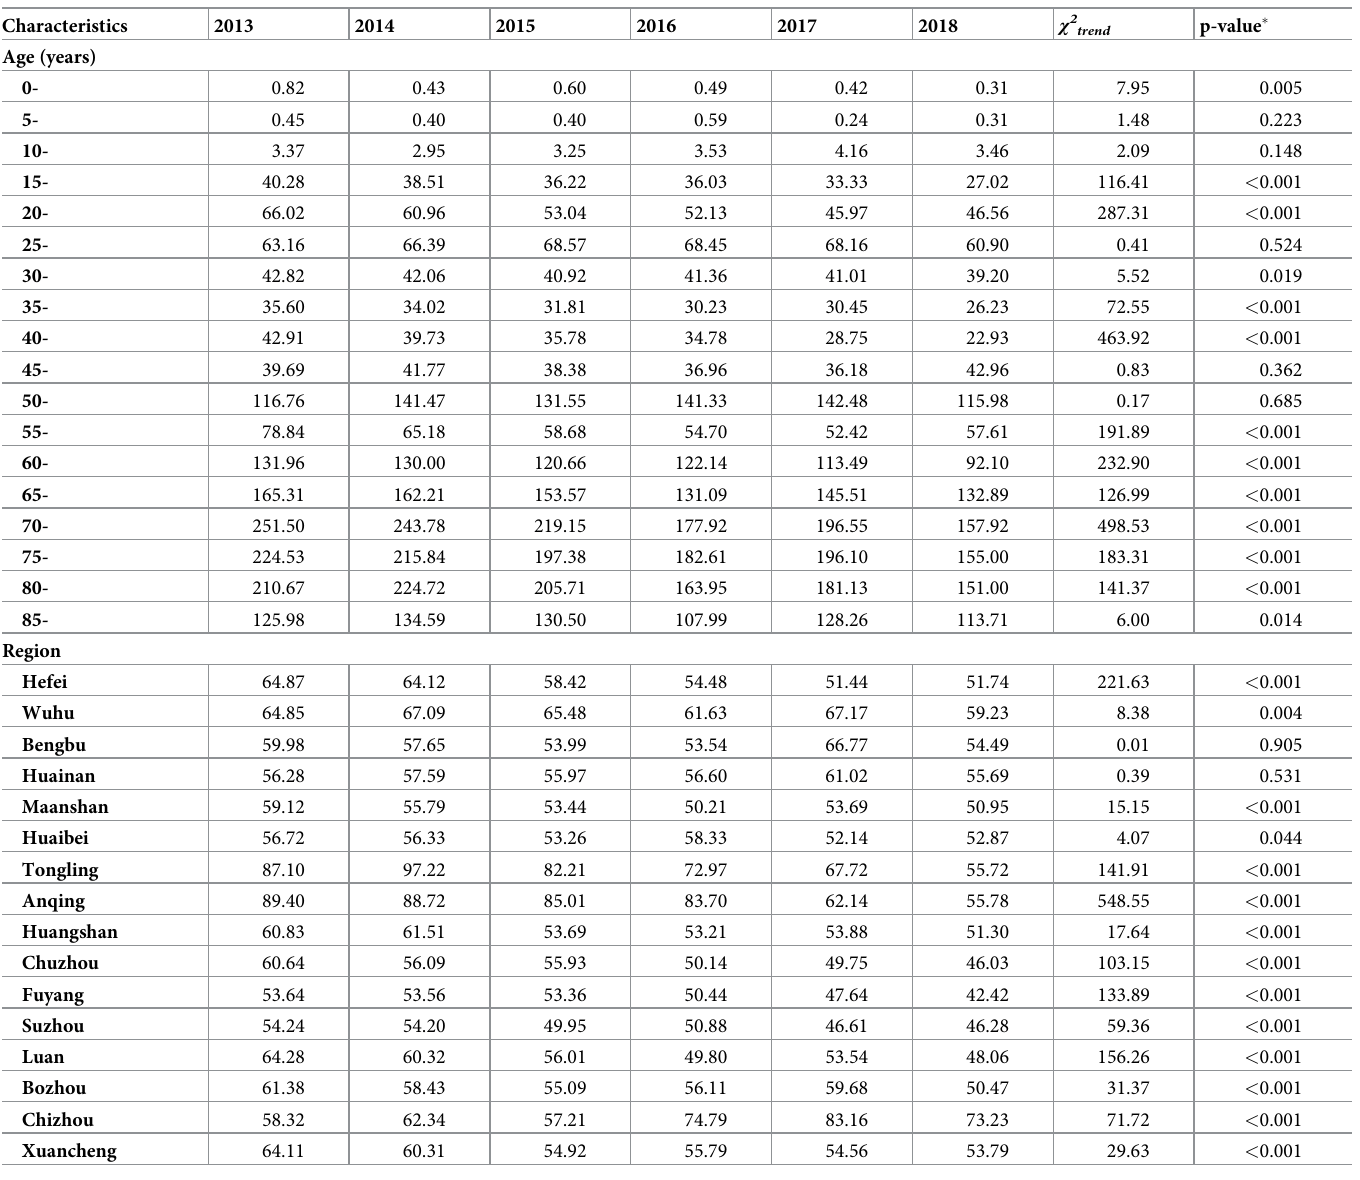
Table 2. Trends in pulmonary tuberculosis incidence rates by age and region in Anhui province, Eastern China, 2013–2018.